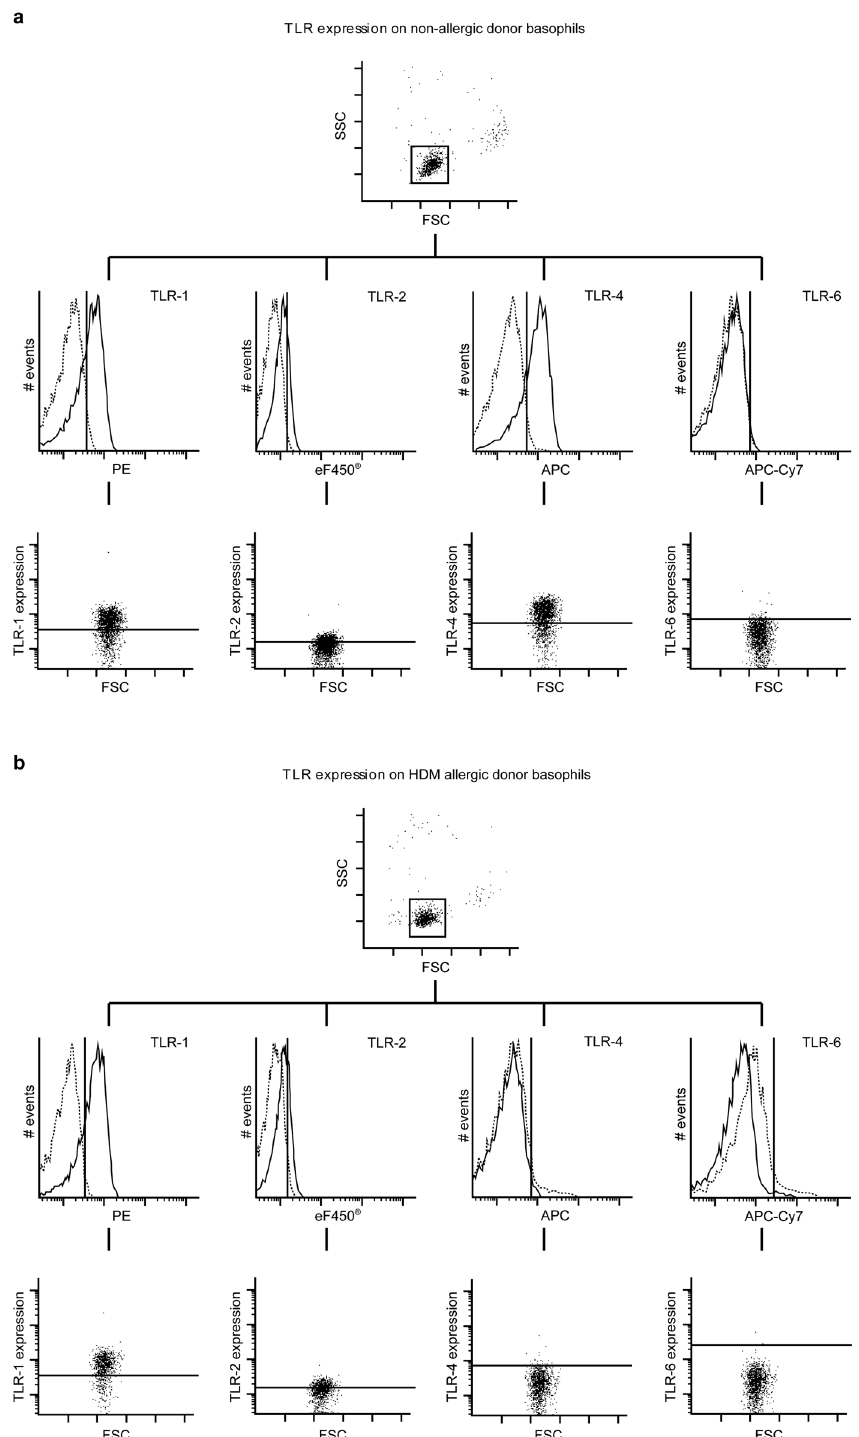
Fig 2. Gating strategy. Shown are one representative non-allergic donor (a) and one house dust mite (HDM)-allergic patient